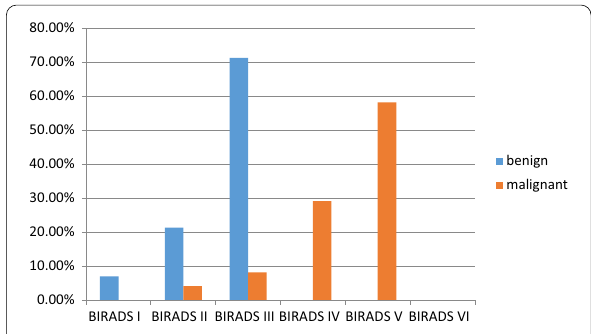
Fig. 1 Correlation between tomosynthesis BIRADS and pathology